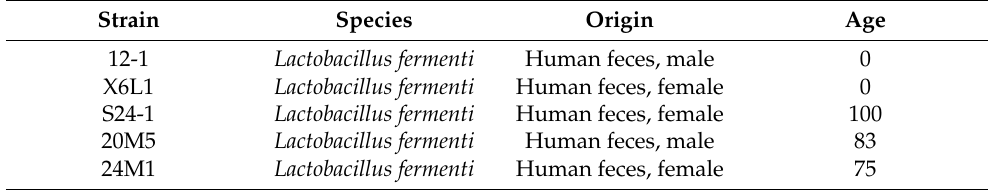
Table 1. Strains used in this study.